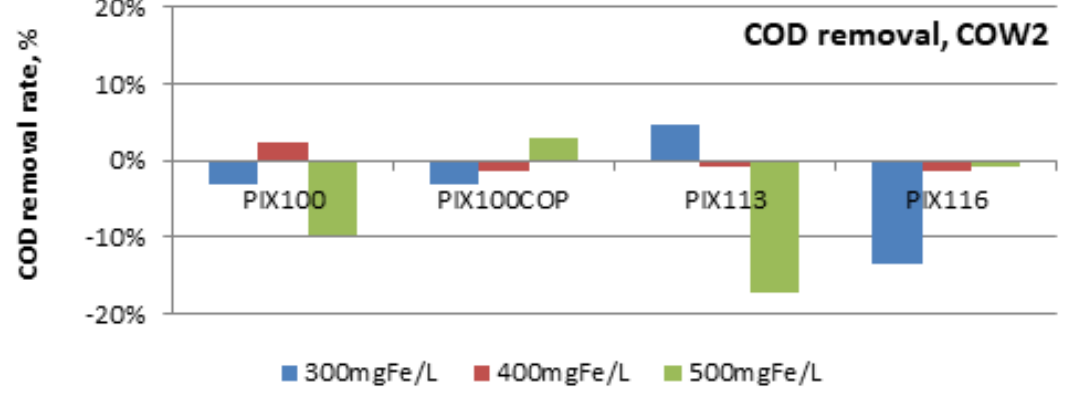
Figure 14: COD removal rate in COW2.